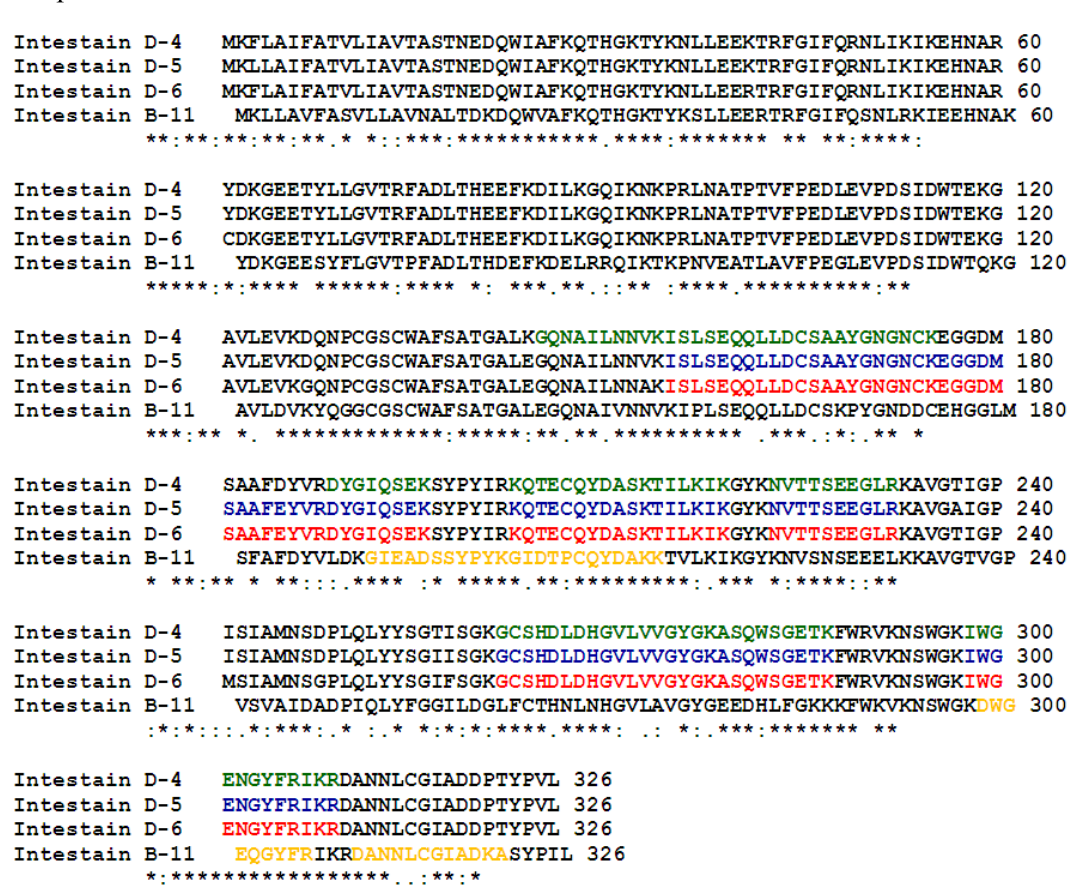
Figure 3. Multiple sequence alignment of CPB intestains D-4, D-5, D-6 y B-11 using Clustal omega [36]. Colored amino acids depict mass spectrometry peptides identified for each